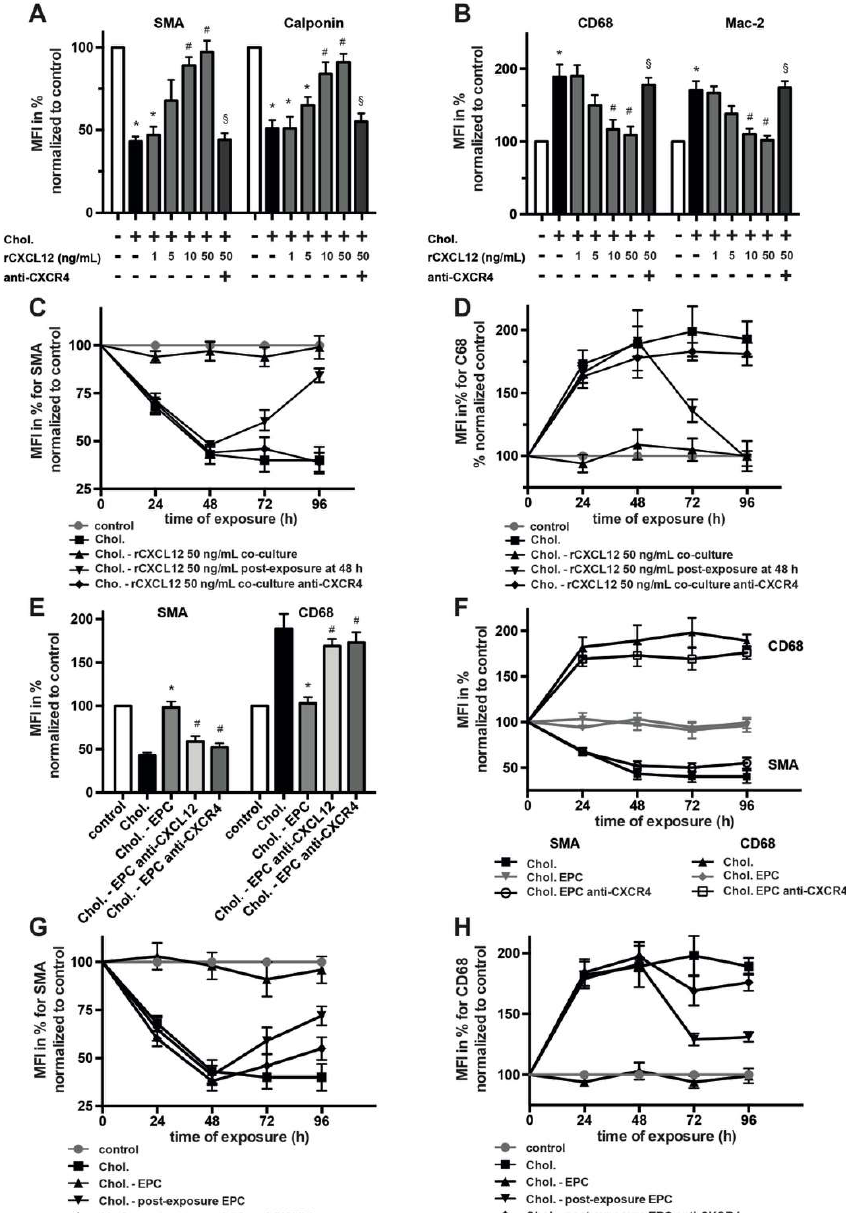
Figure 6 . Engagement of CXCL12–CXCR4 in EPC-mediated protection of cholesterol-induced phenotype switch. SMCs were treated as indicated for various time periods and presence of stated phenotype markers was determined using flow cytometry. Data are expressed as MFI in % normalized to untreated SMCs (control). ( A , B ) Assessment of the transformative potential of CXCL12 in the presence of SMC loading with Chol:MßCD complexes (Chol). SMCs were treated as indicated for 48 h. Anti-CXCR4 Ab and/or rCXCL12 were added to SMCs simultaneously with Chol:MßCD. * p < 0.05 vs. untreated SMCs (control), # p < 0.05 vs. SMCs treated with Chol, § p < 0.05 vs. SMCs treated with rCXCL2 50 ng/mL plus Chol:MßCD; n = 5. ( C , D , F , G , H ) Time course of SMA and CD68 expression by SMCs treated as indicated for various time periods. SMCs loaded with Chol:MßCD were either continuously co-cultured with rCXCL12 or EPCs for up to 96 h or were primary treated with Chol:MßCD for 48 h and only then subsequently exposed to rCXCL12 or EPCs for another 48 h (post-exposure); n = 4 to 6. ( E ) Analysis of CXCL12–CXCR4-dependent and EPC-mediated protection of cholesterol-induced phenotype switch after 48 h. * p < 0.05 vs. SMCs treated with Chol:MßCD, # p < 0.05 vs. SMCs co-cultured with EPCs and treated with Chol:MßCD plus EPCs (Chol.-EPC); n = 4.